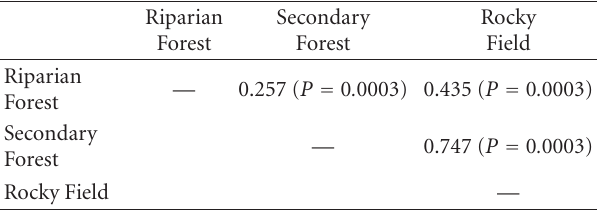
Table 2: Comparisons ANOSIM paired of the composition of ant species in the three phytophysiognomies sampled in the Parque Estadual do Ibitipoca, Brazil. July–December, 2008.